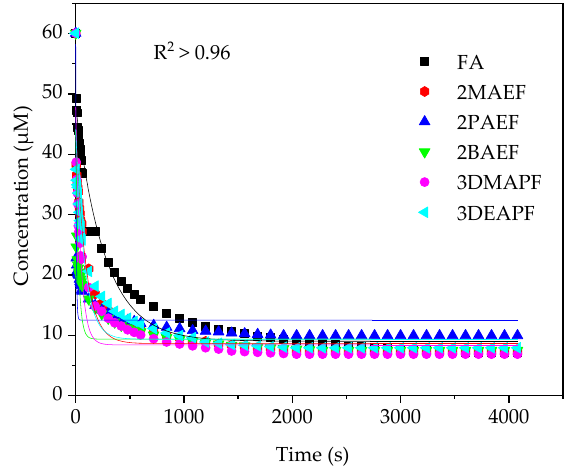
Figure 3. Curve fitting of pseudo first order rate constant ( k 1 ) of synthesized PILs and FA.